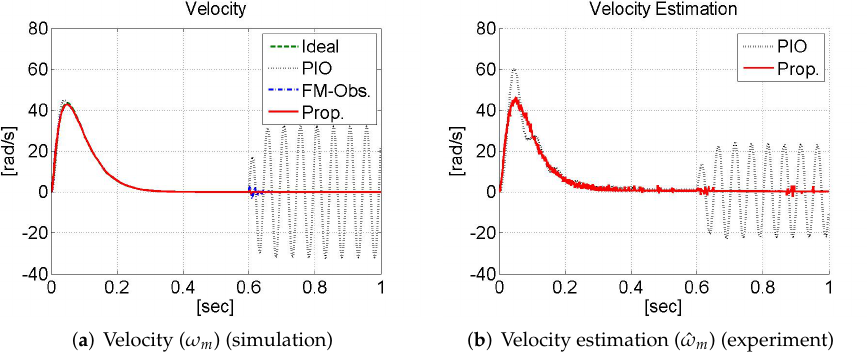
Figure 4. Results of DC motor position.